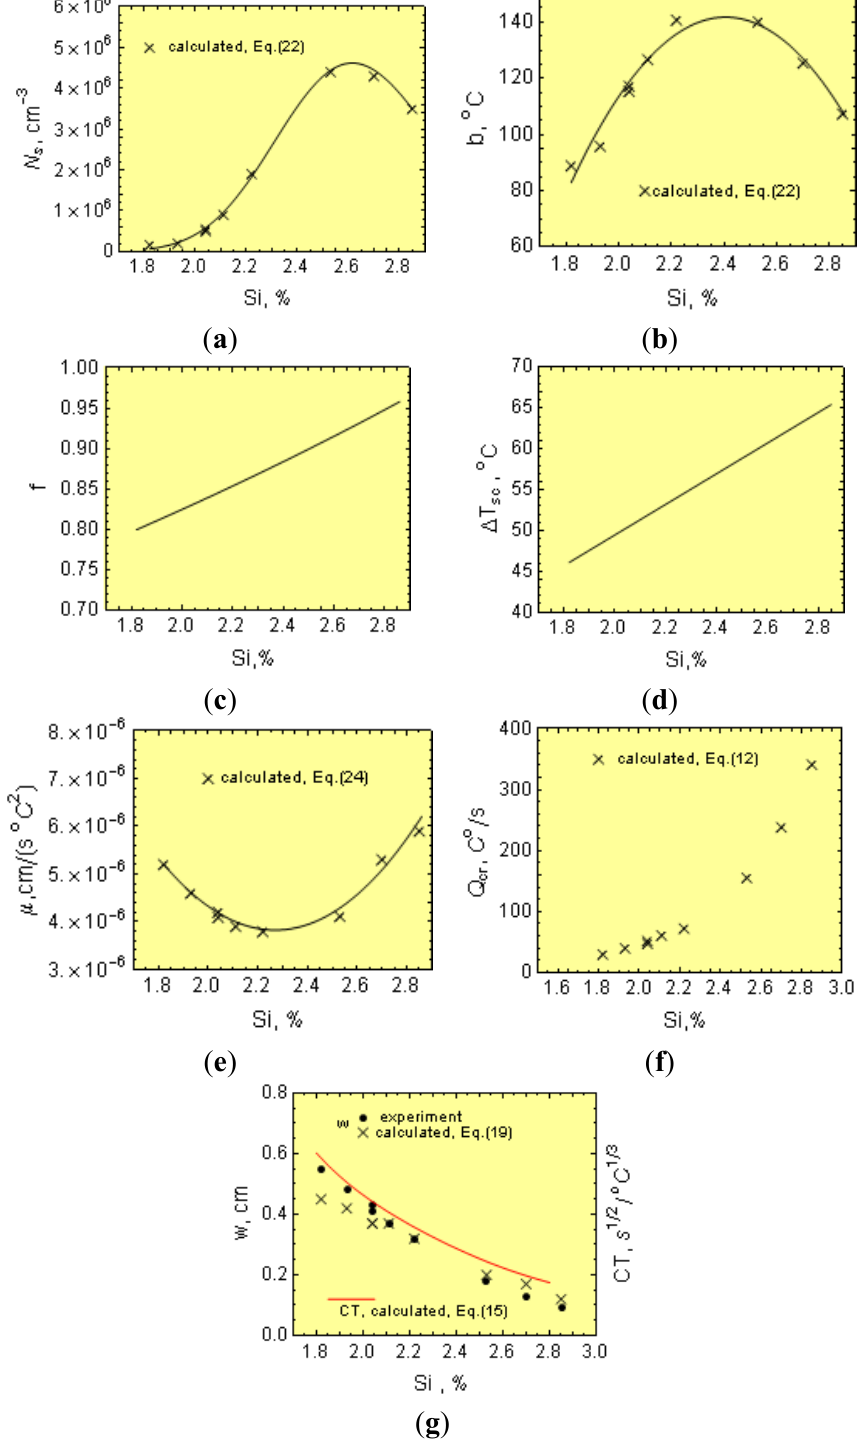
Figure 14. Effect of silicon on ( a ) N s , ( b ) b , ( c ) f , ( d )  T sc , ( e ) μ, ( f ) Q cr and ( g ) the CT index and